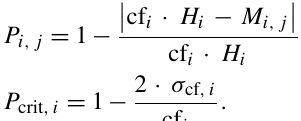
cepted when P i,j >P crit ,i for all target variables i